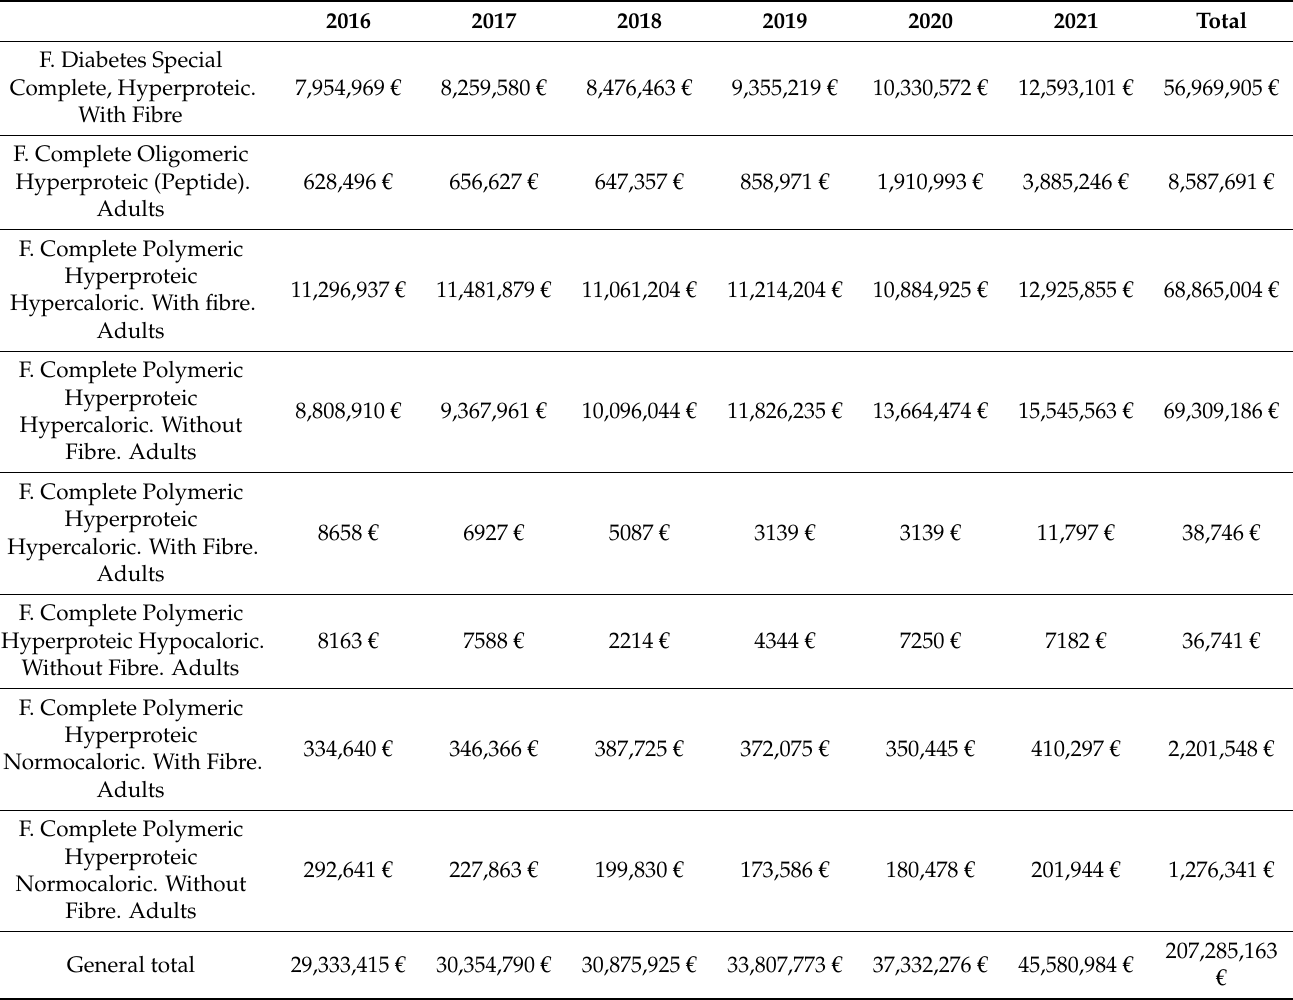
Table 2. Economic impact of hyperproteic diet therapeutics from 2016 to 2021 in the Community of